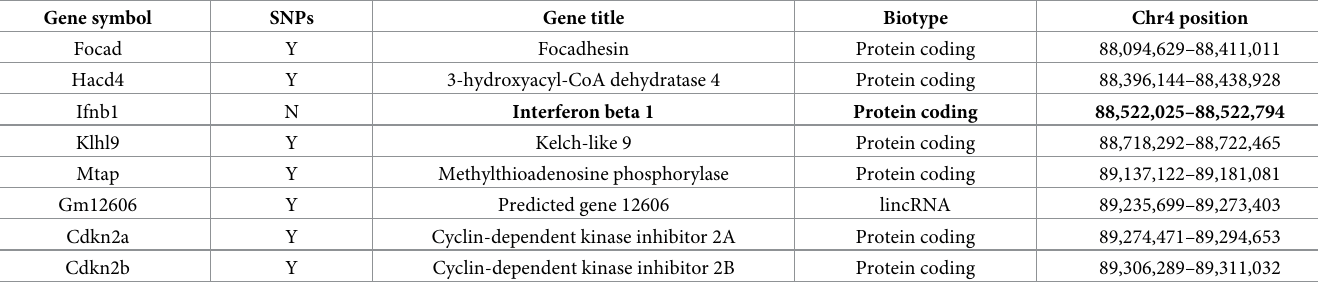
Table 1. RNA-seq identified 6 candidate genes and 1 lincRNA in the 2 Mbps ISRCL5 interval. Gene